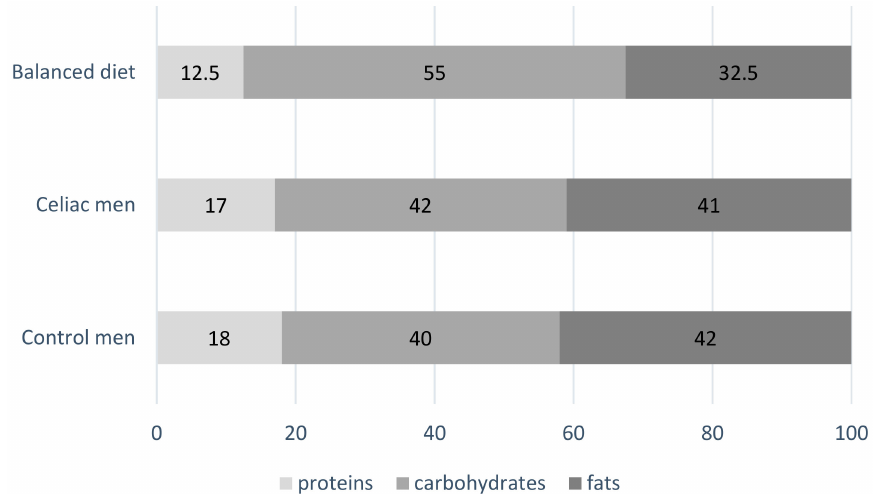
Figure 1. Mean contribution of macronutrients to energy in Spanish celiac ( n = 42) and control men ( n = 1589) (ENIDE study, representative at national level of the adult population) compared to the recommended contribution in a balanced diet proposed by the Federation of Spanish Societies of Nutrition and Dietetics